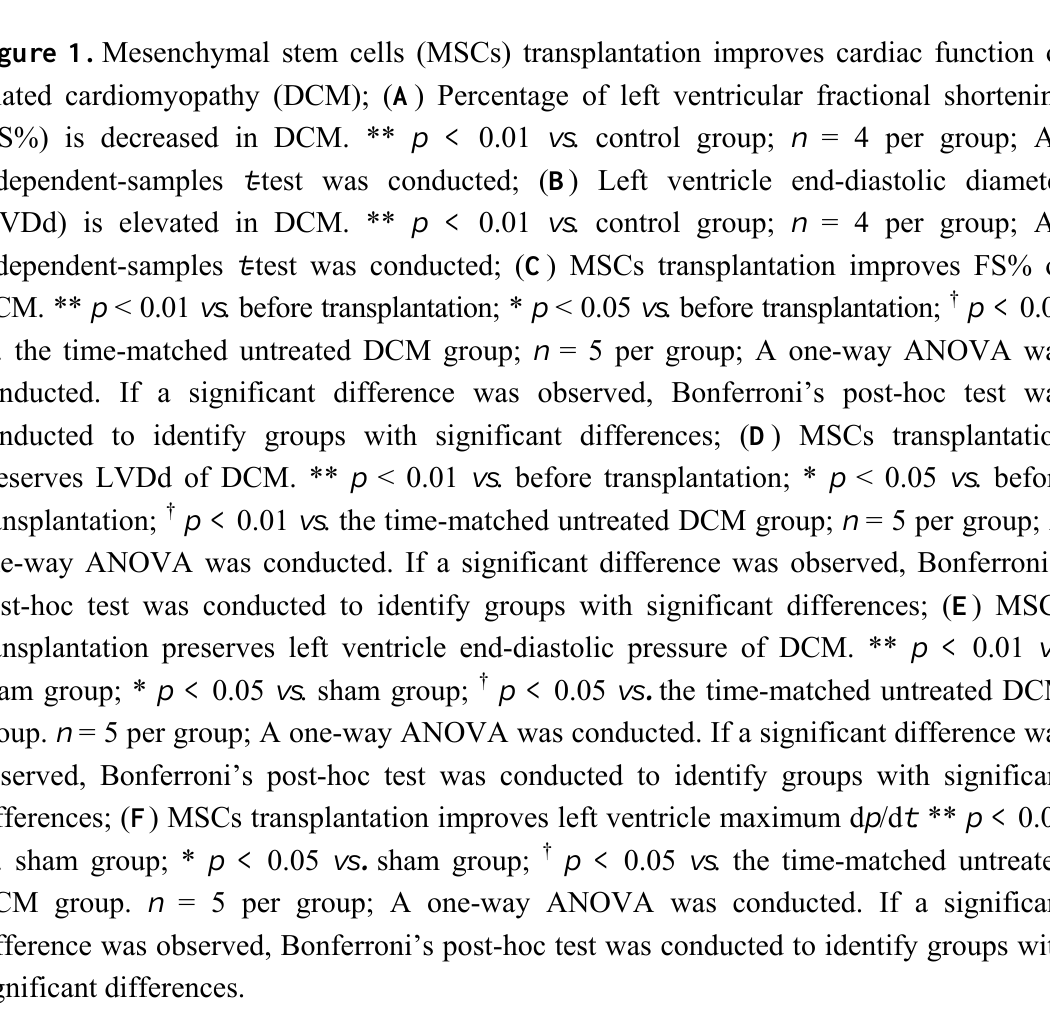
Figure 1. Mesenchymal stem cells (MSCs) transplantation improves cardiac function of dilated cardiomyopathy (DCM); ( A ) Percentage of left ventricular fractional shortening (FS%) is decreased in DCM. ** p < 0.01 vs . control group; n = 4 per group;